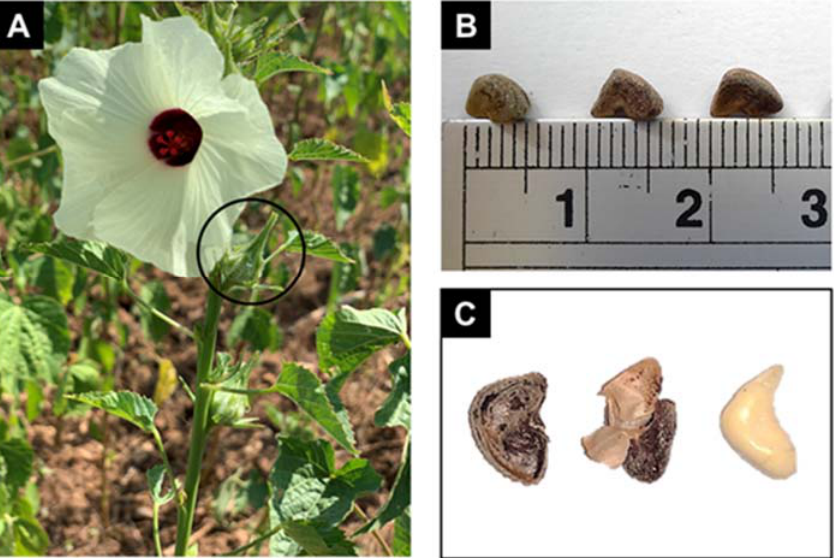
Figure 5. Kenaf plant, kenaf seed size measurement, and kenaf seed components. ( A ) A young kenaf plant with a flower, stem, seed pod, and shoots. ( B ) Measurement of kenaf seed length using a standard ‐ sized ruler. ( C ) From the left are whole kenaf seed, seed hull, and dehulled seed.